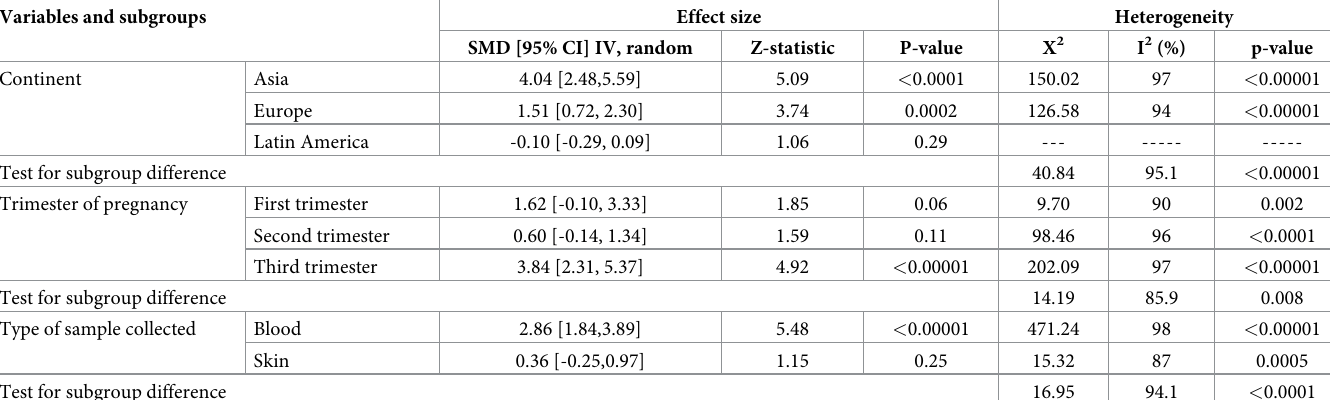
Table 3. Subgroup analysis of outcome measures based on continent, trimester of pregnancy and sample type. Variables and subgroups